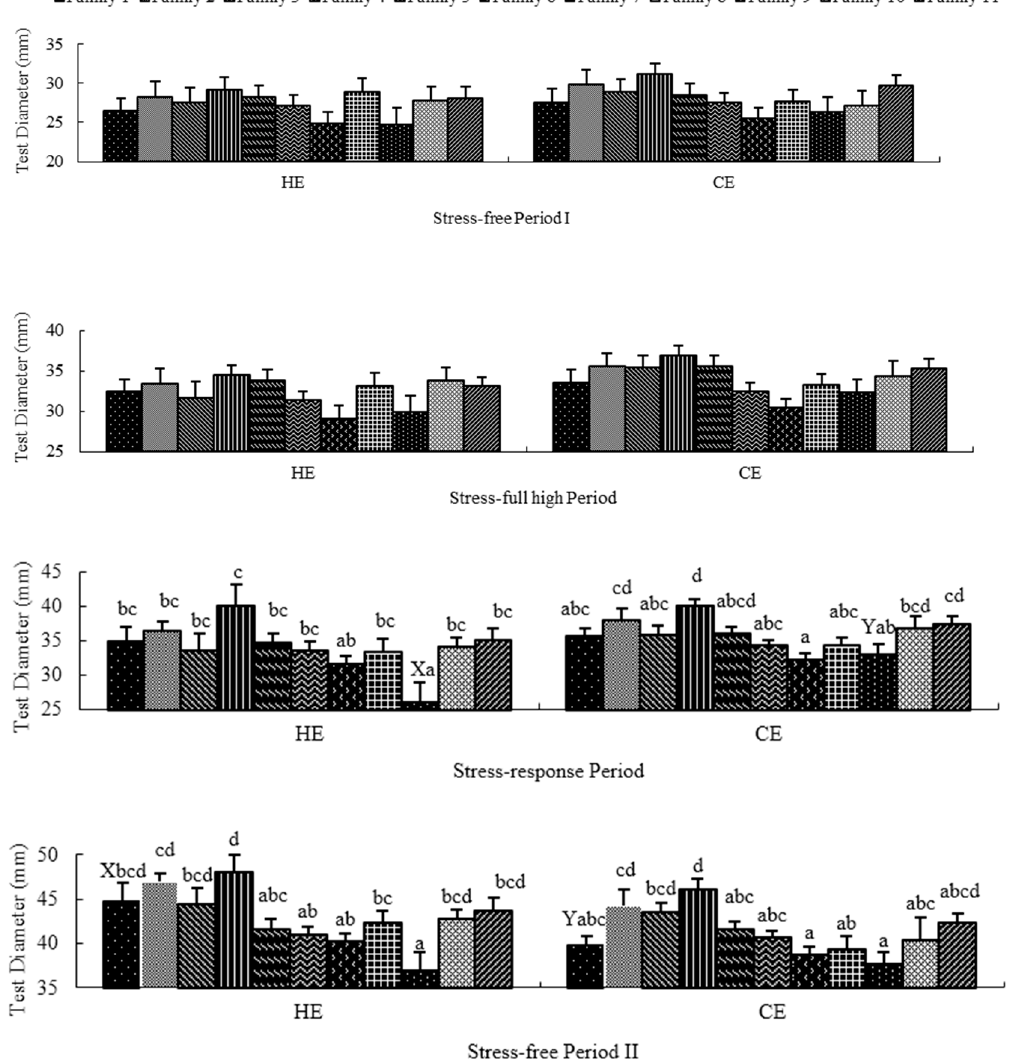
Figure 1. Ranking of families for test diameter in high temperature environment and control temperature environments. The histogram bar indicates mean and standard error of each separate family. In each environment, lower-case letters (a,b,c,d) indicate significant differences between families ( p < 0.05), and upper-case letters (X,Y) indicate significant differences between environments ( p < 0.05).